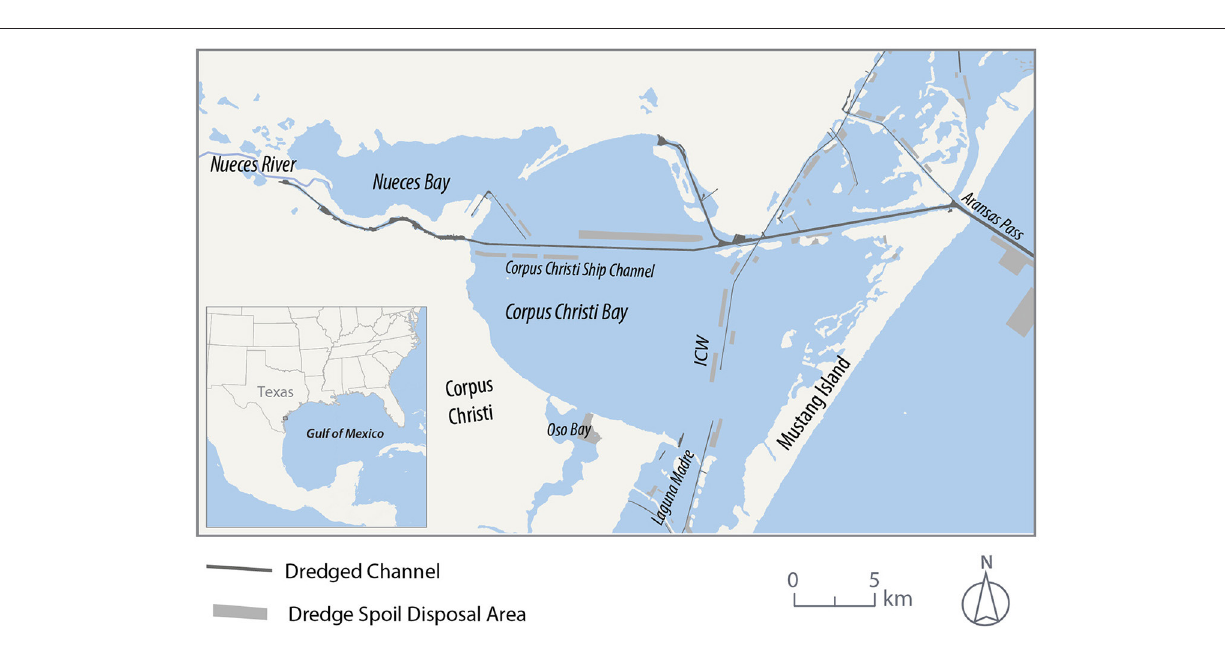
FIGURE 2 | Detailed map of Corpus Christi